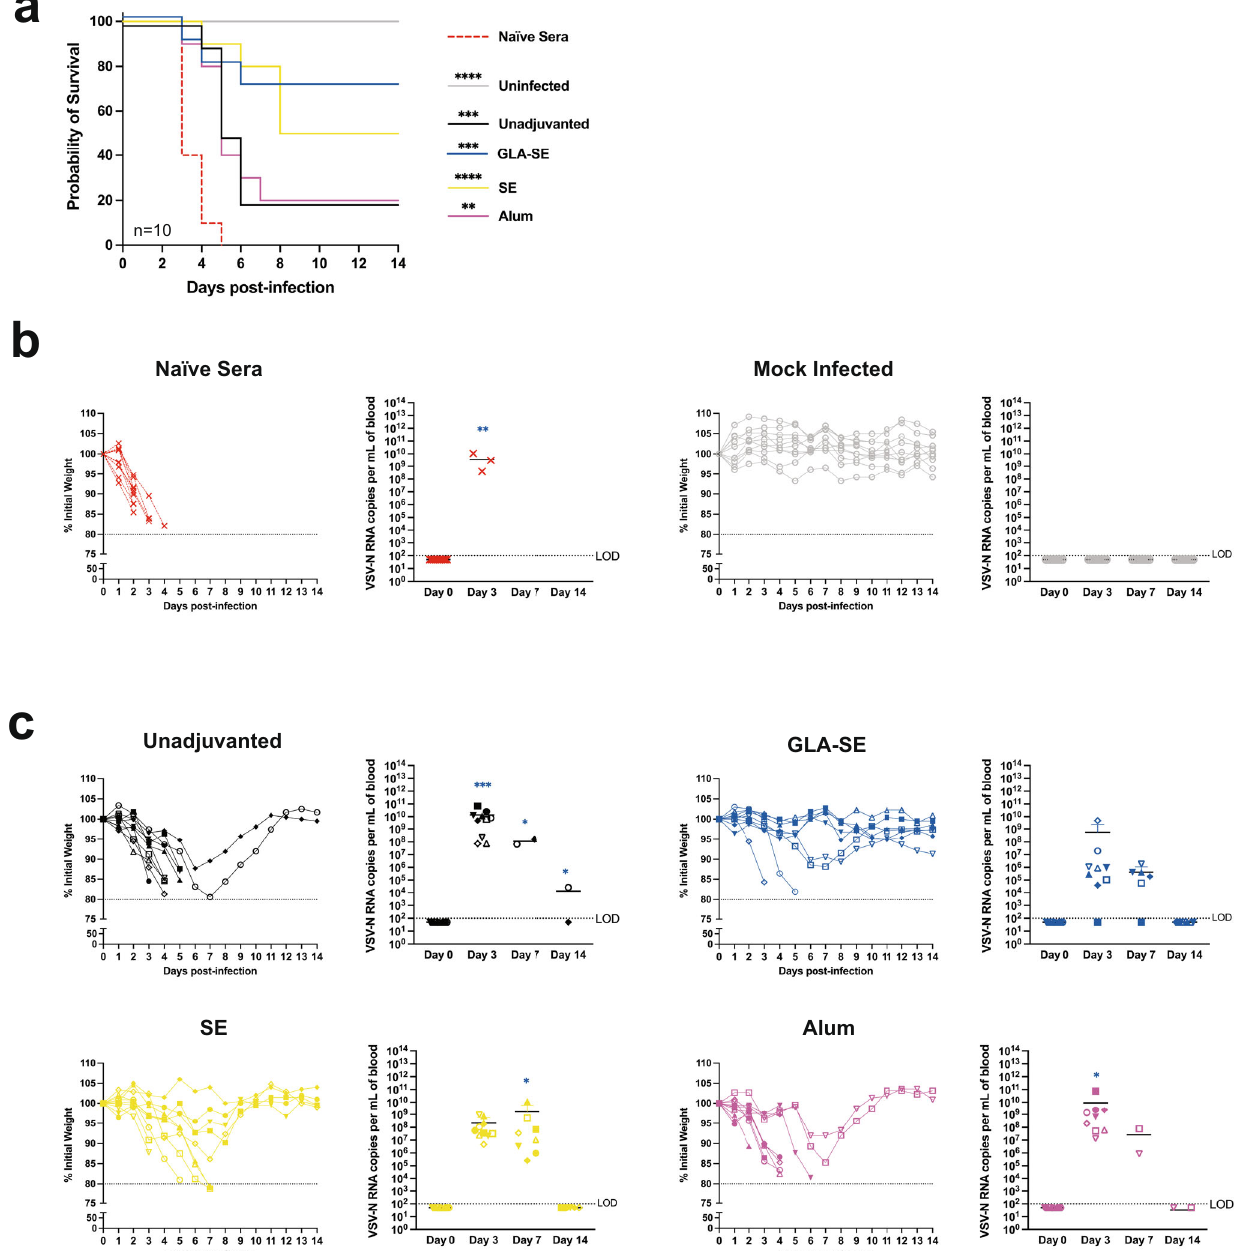
Fig. 5 Passive transfer of immunized mouse sera is suf fi cient for protection from surrogate infection. a Survival of IFNAR − / − mice infected intraperitoneally (IP) 24 h after passive transfer of C57BL/6 immunized mouse sera. Mice were challenged with a lethal dose of VSV Δ G-EBOV- GP (5 × 10 5 PFU). b Weight loss and qPCR of VSV-N RNA in experimental control groups including mice transferred naïve sera and mock challenged mice. c Weight loss and qPCR of VSV-N RNA in FILORAB1 and adjuvant formulation immunized mice post-infection. Limit of detection (LOD) is 100 copies per/mL (dotted line). Statistics are by simple survival Kaplan-Meier analysis and one-way ANOVA with post hoc Tukey ’ s test of log-transformed RNA copy number. p > 0.1234 (ns), p < 0.0332 (*), p < 0.0021 (**), p < 0.0002 (***), p < 0.0001